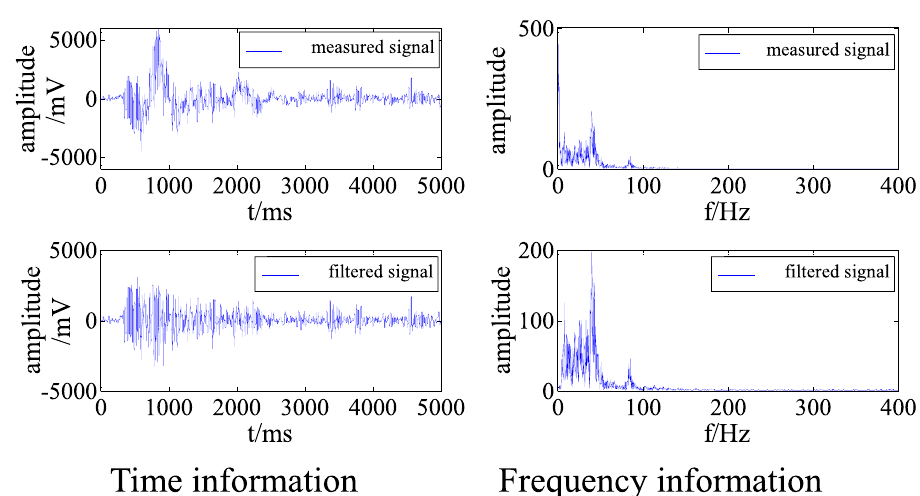
Figure 9. Time and frequency information for channel 02 before and after